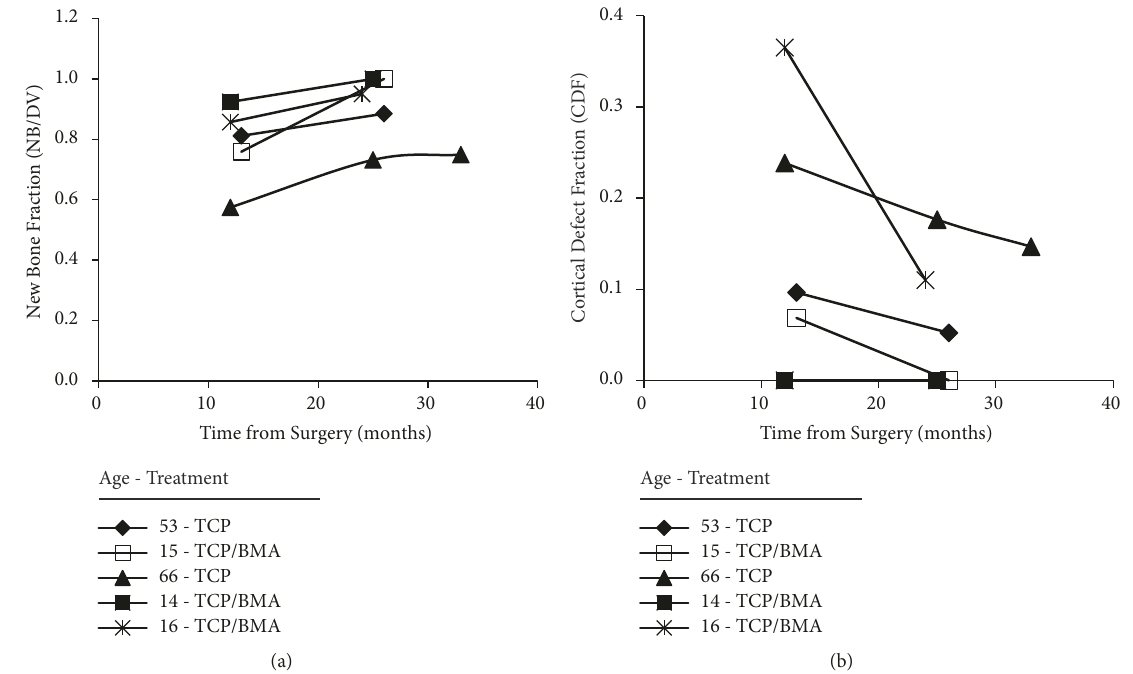
Figure 9: Medullary new bone fraction (a) and cortical defect fraction (B) as a function of months of healing for the five patients with more than one serial CT scan. Note that progressive improvement in medullary NB formation (incorporation) occurred in all of the five patients (a) and progressive decrease in cortical defect fraction (defect graft incorporation) occurred in four out of the five patients